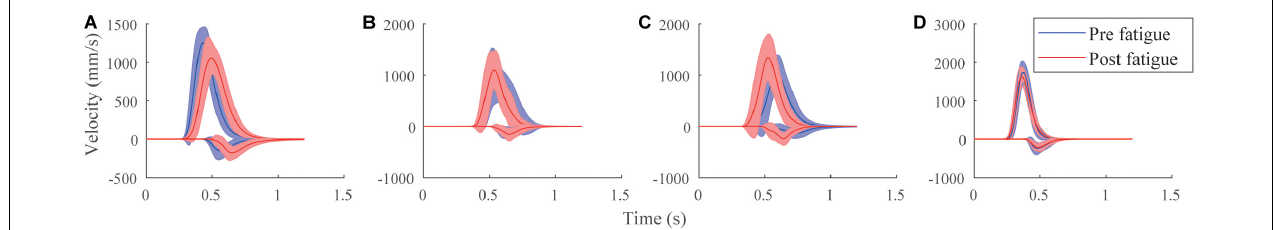
FIGURE 5 | Velocity profiles of four participants with the mean ± SD of the simple strokes, before (blue) and after (red) fatigue for the agonist (positive) and antagonist (negative) components. Panel (A) had a significant increase after fatigue in µ , mode , median , time delay , RT for the agonist parameters; and t 0 , σ , response time , asymmetry , and RT for the antagonist parameters. Panel (B) had no statistical changes. Panel (C) had a significant increase in D for the agonist parameters. It had a significant decrease in |cos ( θ s ) | , µ , mode , median , time delay , Nblog in the agonist parameters and SNR and TR in both components. Panel (D) had a significant increase after fatigue of t 0 , σ and |t 0 -RT| and a significant decrease in µ and RT in the agonist parameters.